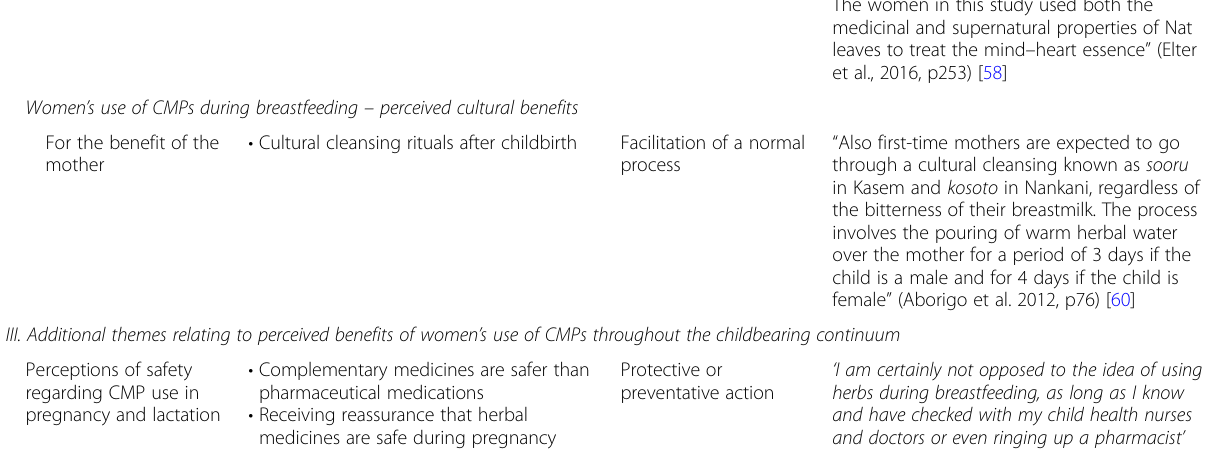
Table 3 Thematic analysis: women ’ s use of CMPs in pregnancy and lactation and perceived benefits (Continued) Women ’ s use of CMPs during breastfeeding – perceived cultural benefits For the benefit of the mother